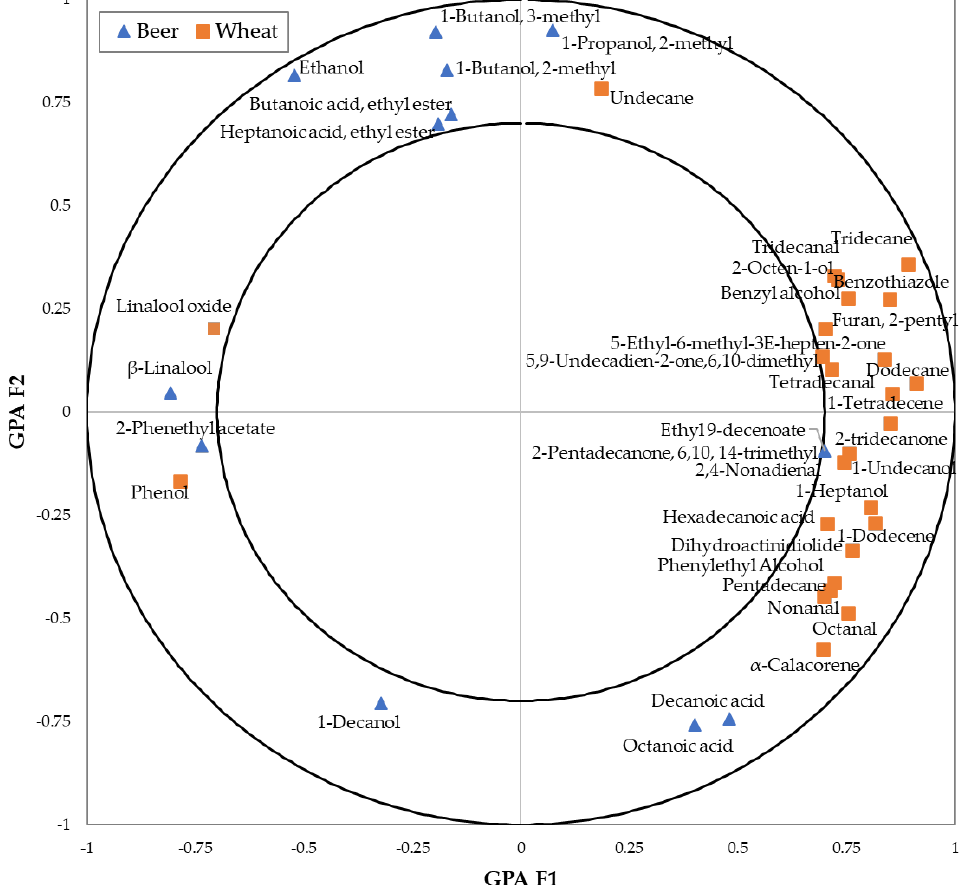
Figure 2. Consensus map, presented by configuration (wheat kernels and wheat beers), obtained by GPA along the F1 and F2 components ( a ); F3 and F4 components ( b ). Score nomenclature: (V) Vittorio wheat; (S) Solina wheat; F1: 70 m a.s.l.; F2: 500 m a.s.l.; F3: 1200 m a.s.l.